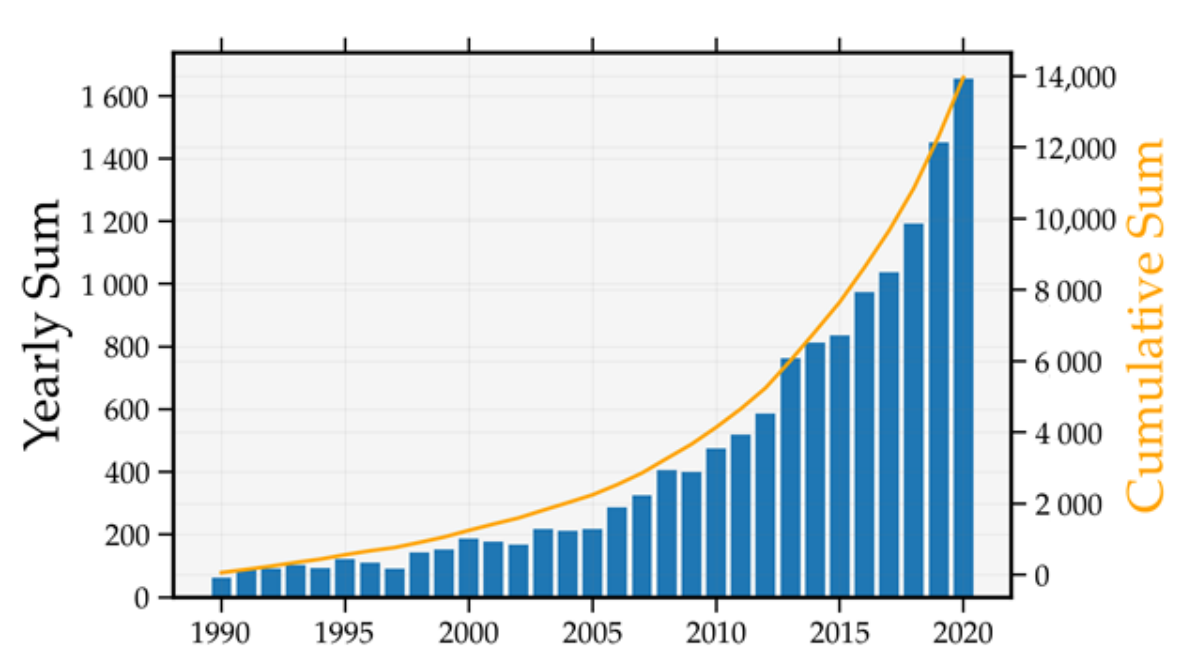
Figure 1. Annual number of papers published on the human right to water and sanitation. * Figures exclude records that lacked an abstract.